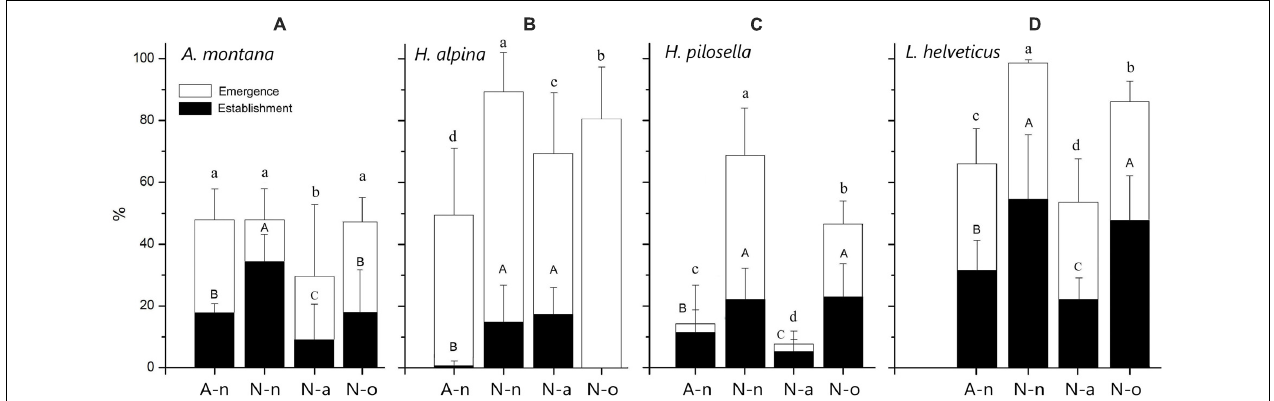
FIGURE 3 | Final seedling emergence and establishment percentage ( ± 95% CI) for all species at the alpine vegetation belt (site A) on its natural soil (A-n) and at the nival vegetation belt (site N) on its natural soil (N-n), on soil originating from site A (N-a) and under the OTC (N-o). Within each panel different letters represent significant ( P < 0.05) differences of emergence (lower-case) and establishment (upper-case).